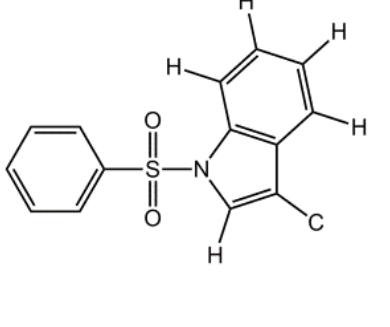
Figure 10. Generic 1-(arylsulfonyl)indole structure employed in the CSD